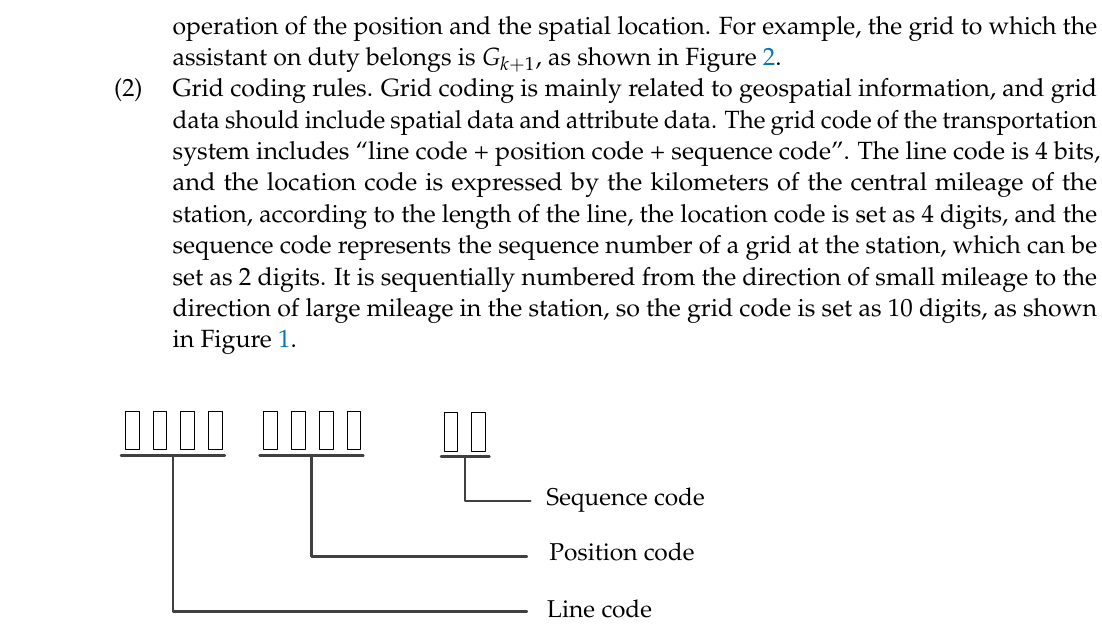
Figure 1. Railway station grid division.